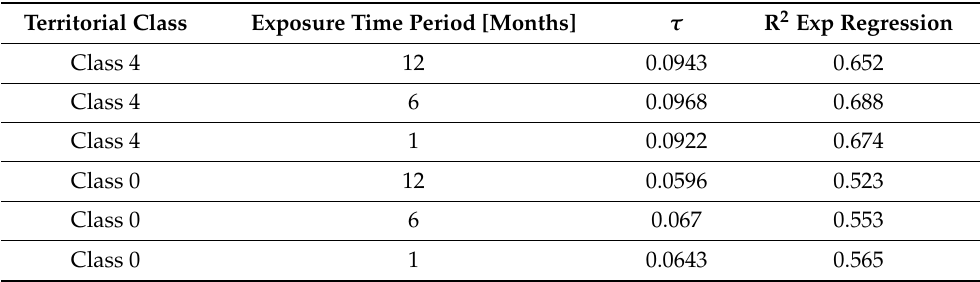
Figure 6. Bar chart representation of all the correlation coefficients between the estimated speed of COVID-19 diffusion and the average concentration of nine different pollutants computed in the previous 12, 6, and 1 months, separately for the four classes representing comparable territorial areas (see text for details); values in bold highlight correlation coefficients with a p -value < 0.05. Class 0: prevalently agricultural; Class 2: mixed land utilization with prevalent urbanized areas; Class 3: mainly natural area with higher income; Class 4: mixed land utilization with prevalent agriculture/natural areas. Table 3. Results of exponential regression between ammonia concentration indicators and the esti- mated speed of COVID-19 diffusion, measured with the parameter λ d computed from the ambulance dispatches, in the different TCs and exposure time windows where R 2 was higher than 0.5; the τ parameter represents the slope of this exponential